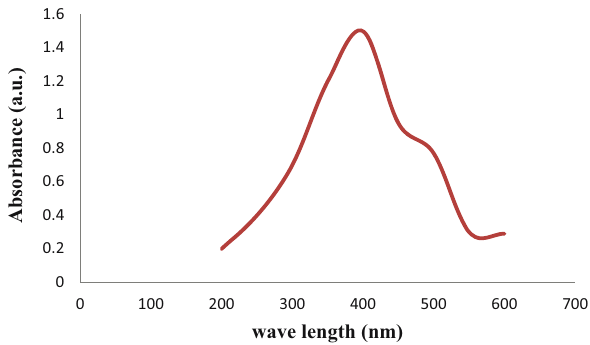
Figure 1: UV - vis spectral analysis of the biosynthesized AgNPs prepared with aqueous R. o ffi cinalis leaf extract.